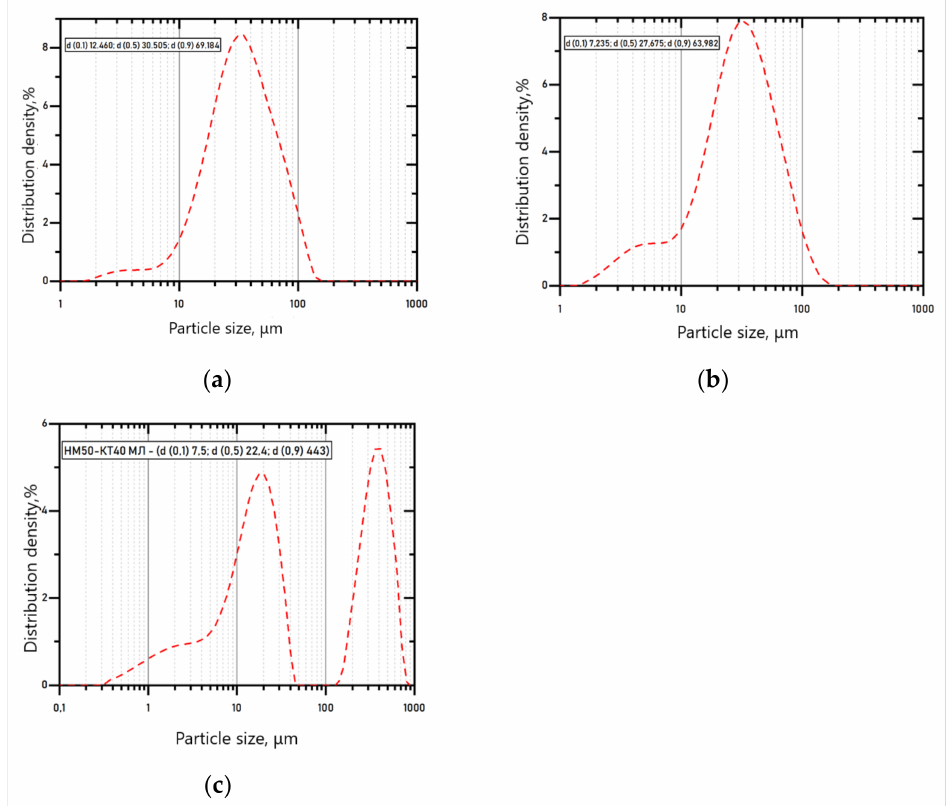
Figure 4. The results of the fractional composition study of the powders: ( a ) mechanical mixtures Ni60-Cu40, ( b ) mechanical mixtures Ni60-Zn40; ( c ) mechanically alloyed powder (Ni50-Cu50)60- TiC40